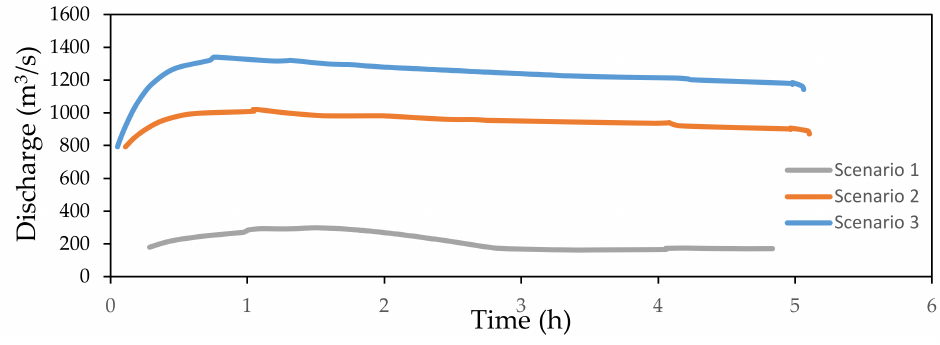
Figure 10. Dam-break flood flow curve under scenarios 1, 2, and